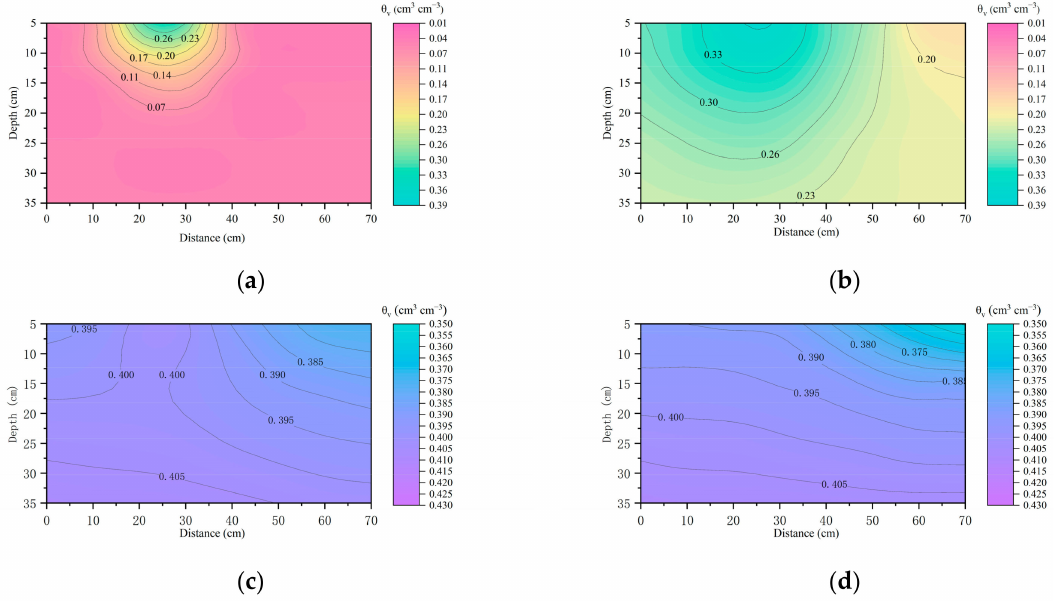
Figure 5. The simulated contours of soil water content under W2: ( a ) The middle of first irrigation; ( b ) the middle of third irrigation; ( c ) the middle of fifth irrigation; ( d ) at the end of